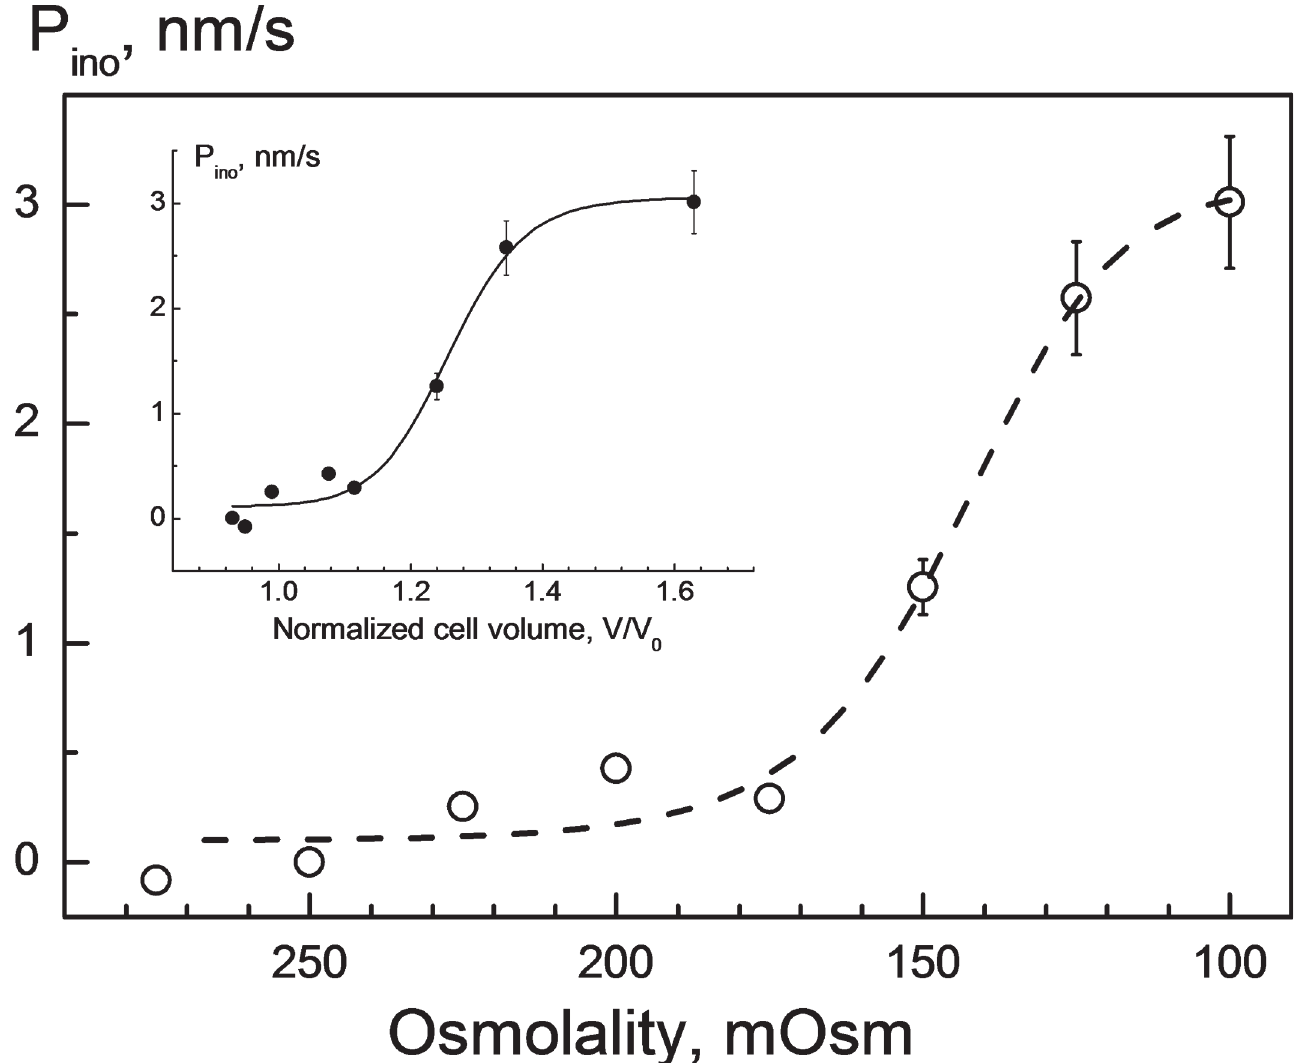
Fig 3. Impact of hypotonicity on the myo-inositol permeability P ino in HEK293 cells. The P ino values were calculated using Eq. 2 from the rates of secondary swelling, using the volumetric data shown in Fig. 2A. The fit of Eq. 3 to the data yielded a C 50 value of 144 ± 10 mOsm, i.e. the tonicity at which the myo-inositol permeability was half-activated. In the inset, the same P ino data are plotted as function of the cell volume at the time point of myo -inositol application. Curve fitting (Eq. 3) shows that P ino was half-activated as cells swelled by about 26% ( v 50 = 1.26 ± 0.02).